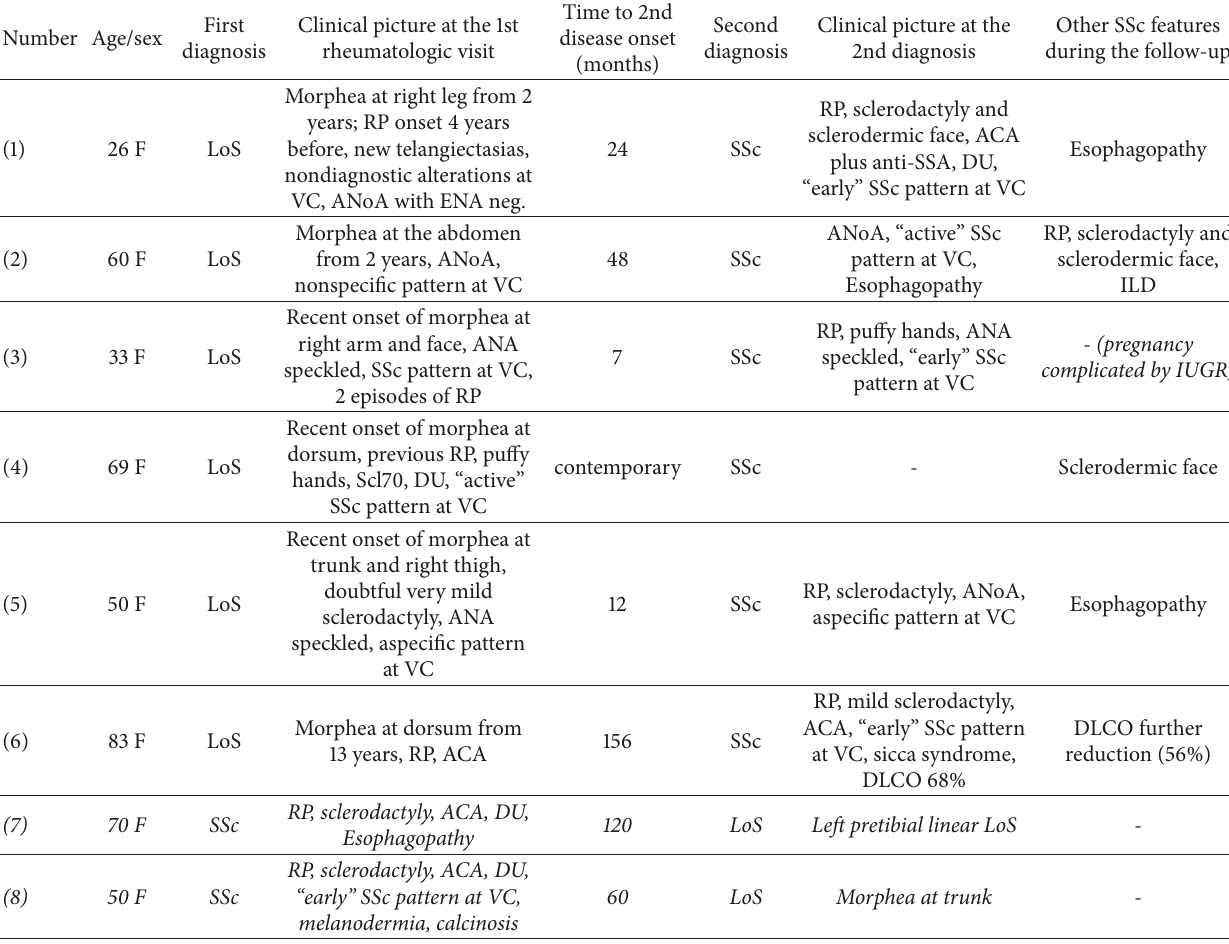
Table 1: Summary of the patients of our series with LoS associated with